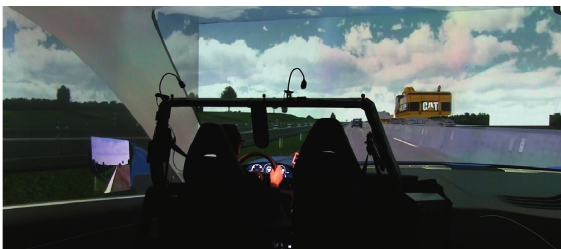
Figure 1: The hexapod simulator during a takeover scenario. The participant has regained manual control and made a lane change to the left lane. Roadworks can be seen behind the wall in the right lane.